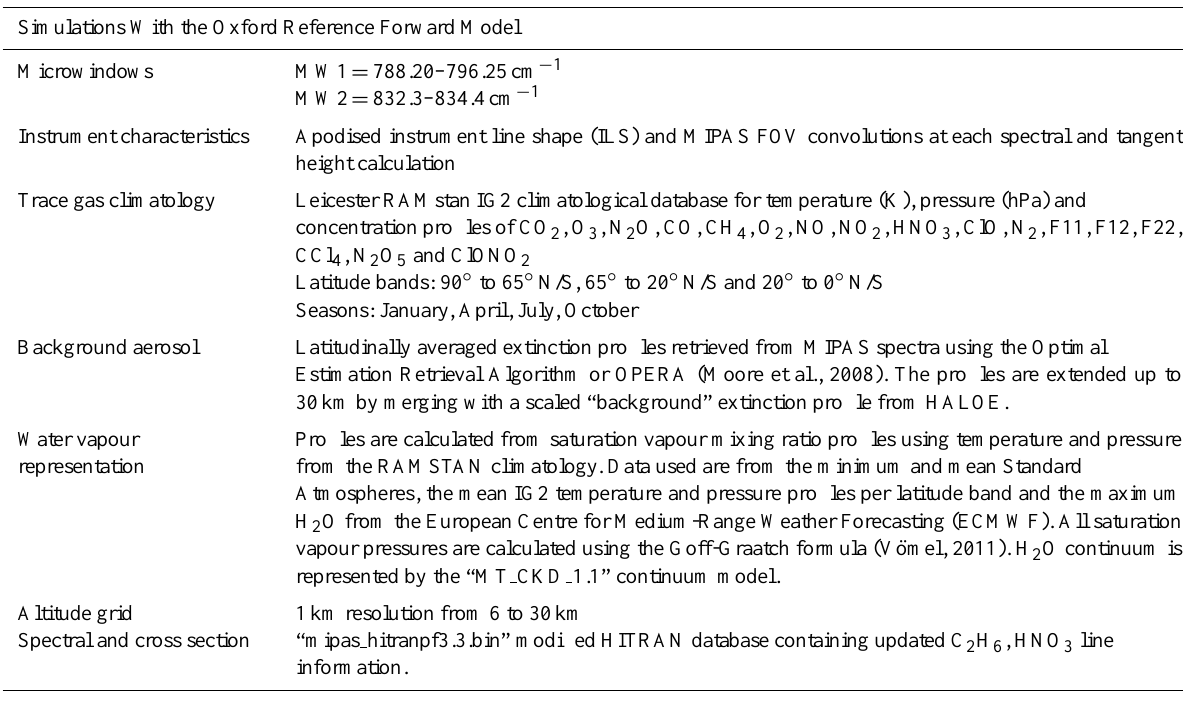
Table 2. Details of MIPAS cloud microwindow